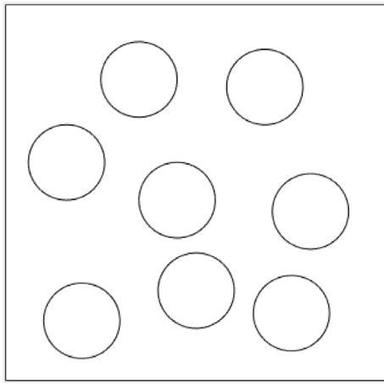
RVE model with eight circular inclusions to examine the capability of RVE-net for knowledge transfer from a trained network.